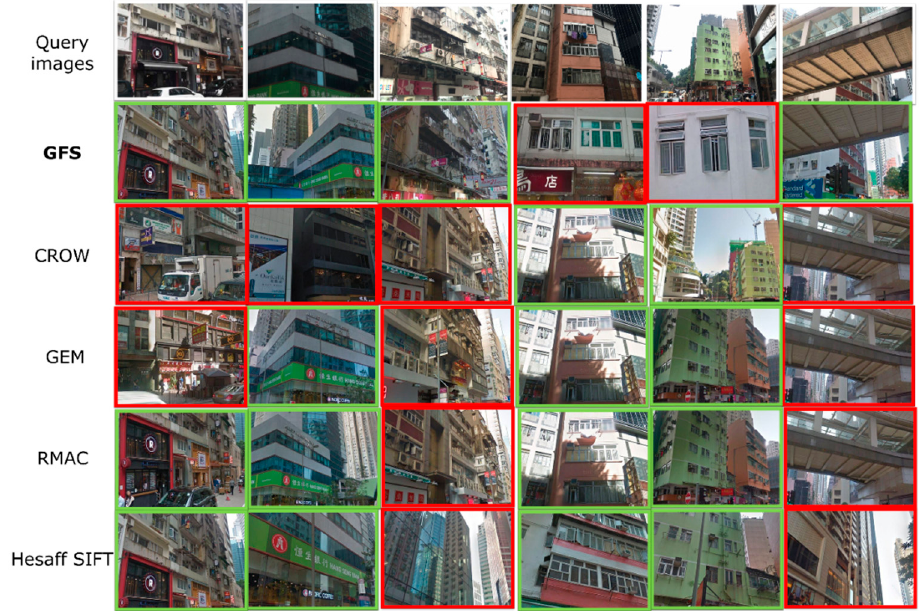
Figure 10. Comparison of the results with other methods. The green boxes are the correct result, while the red boxes are the incorrect result.